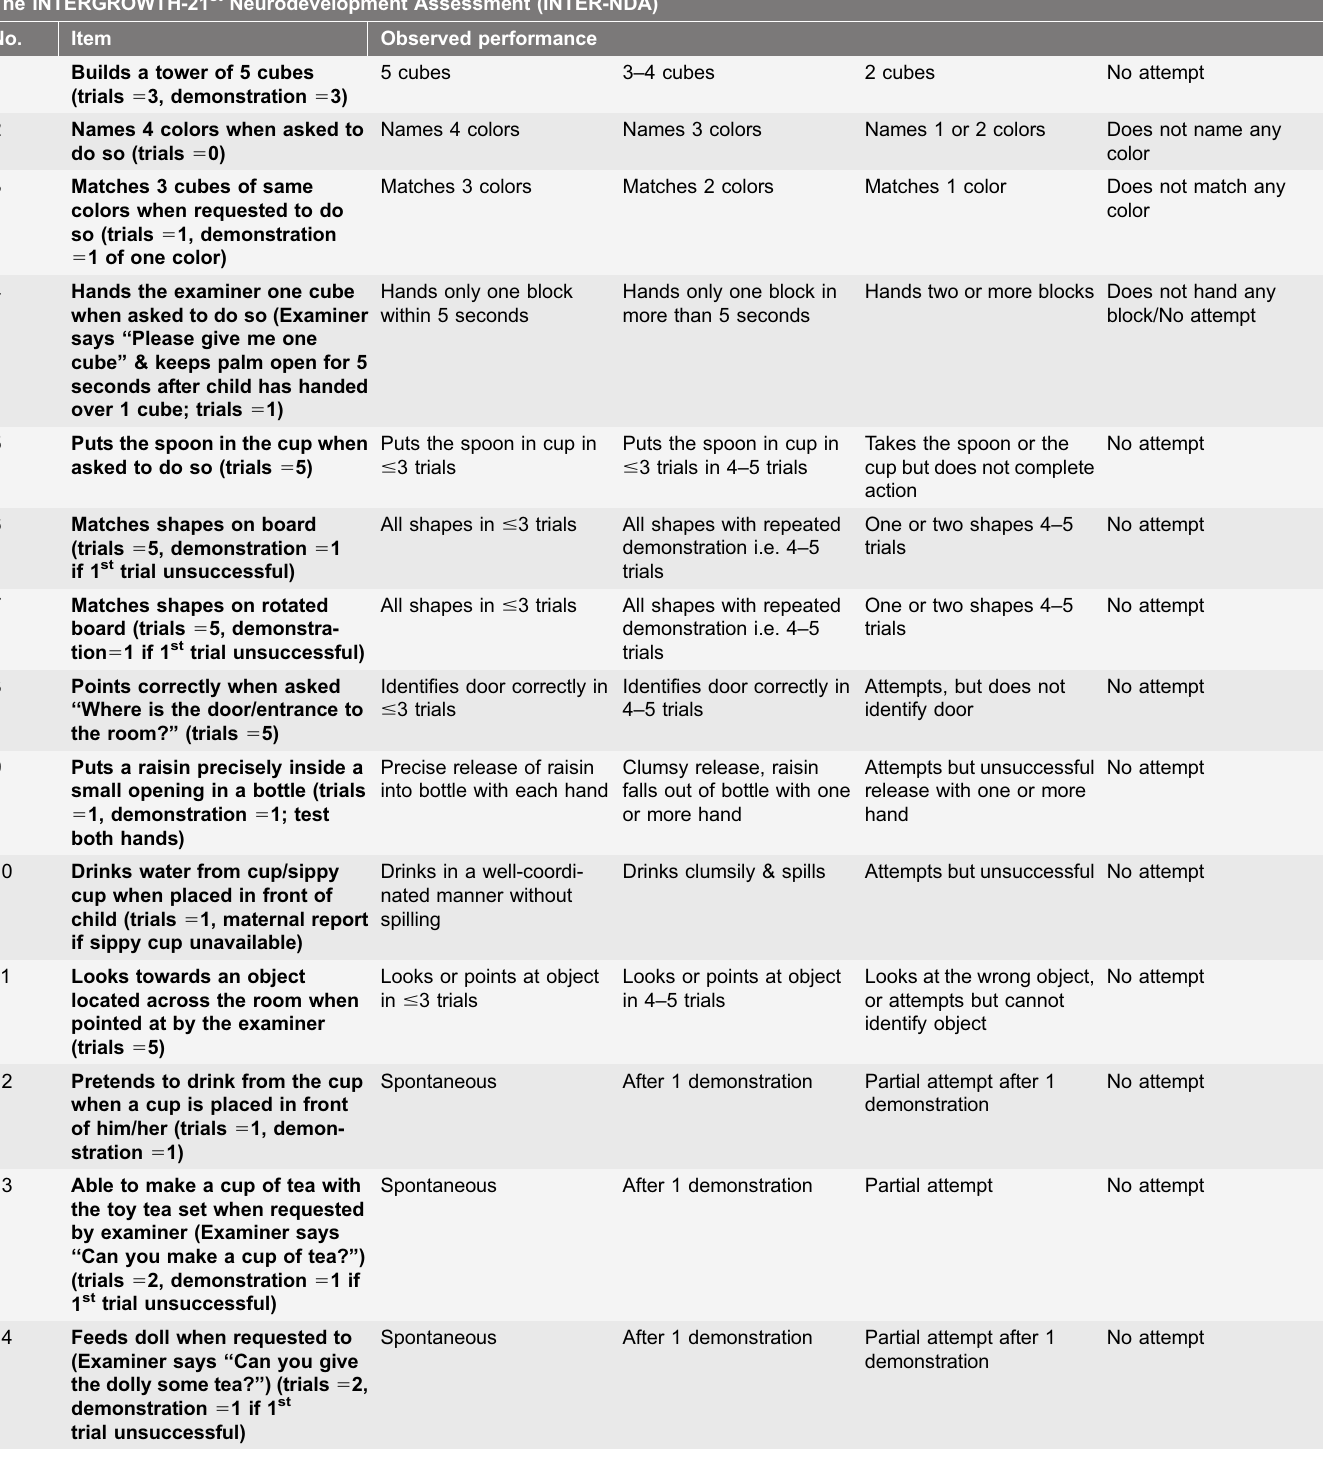
Table 9. Constituent items and scoring sheet of the INTERGROWTH-21 st Neurodevelopment Assessment. The INTERGROWTH-21 st Neurodevelopment Assessment